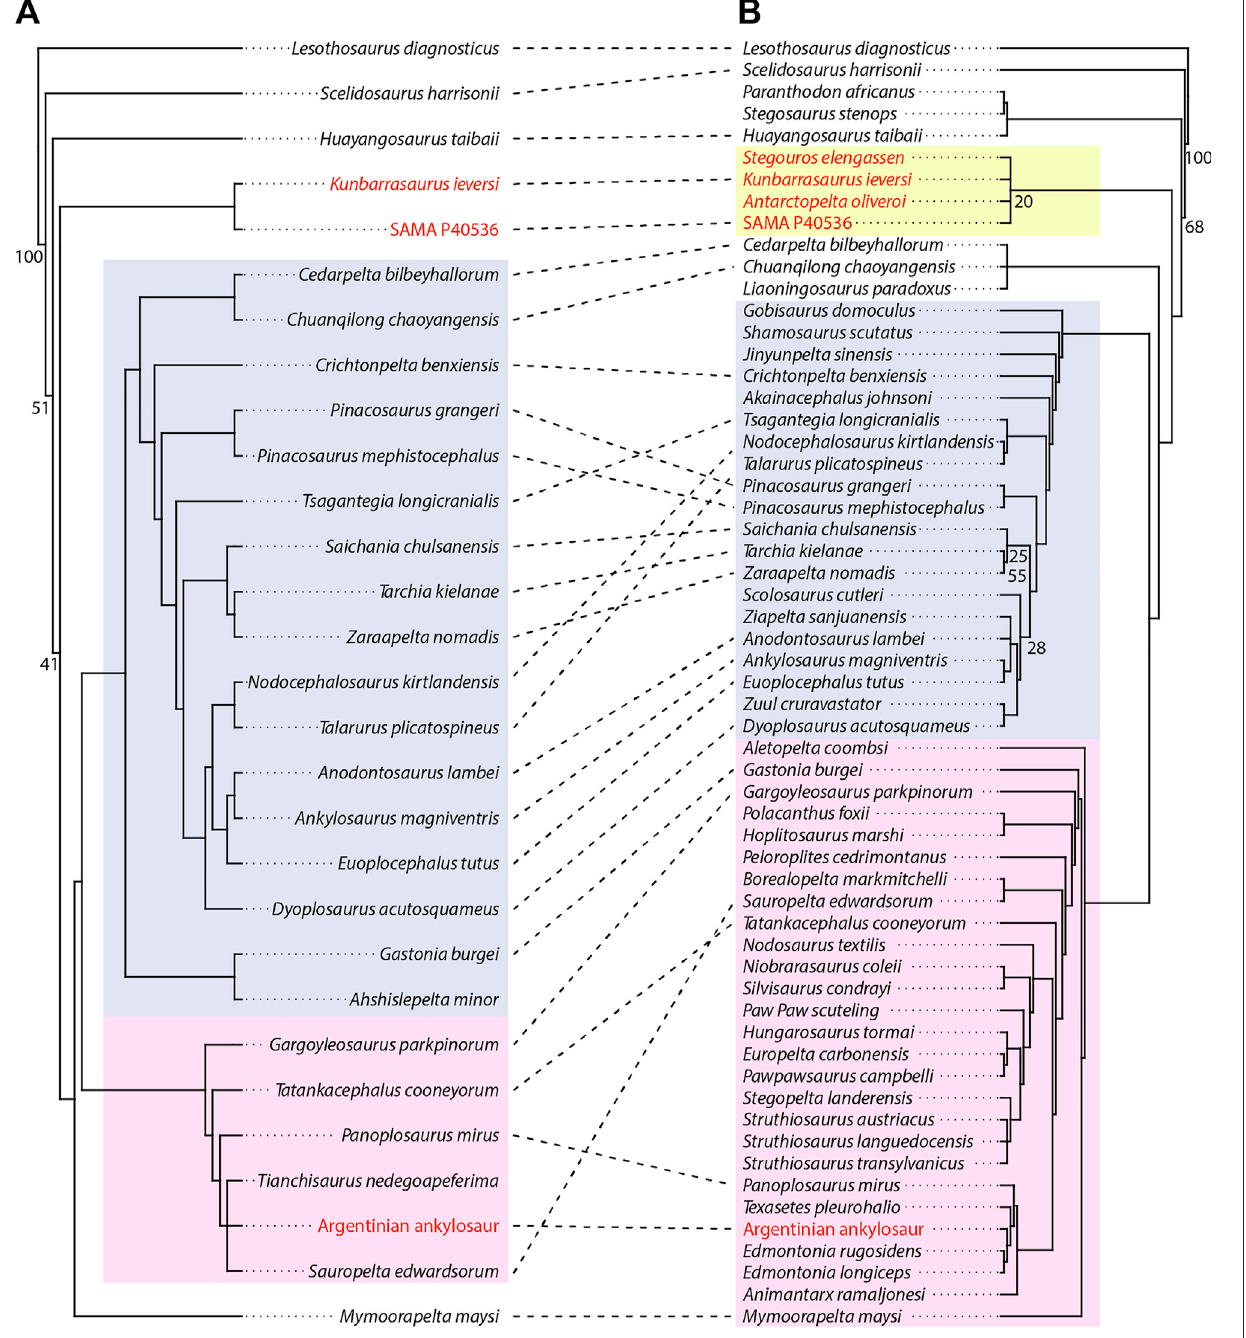
summarised using the Groups present/Contradicted (GC) metric.